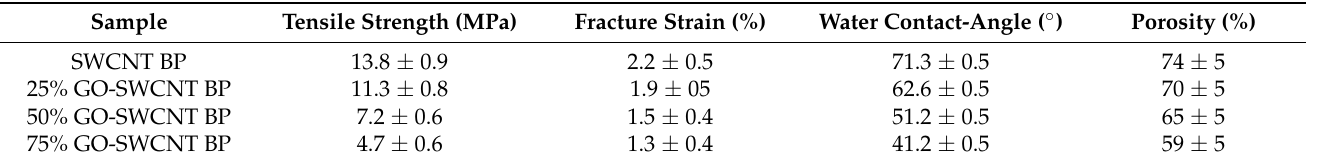
Figure 3. Stress-strain curves of SWCNT BP with different weight percentage of GO.